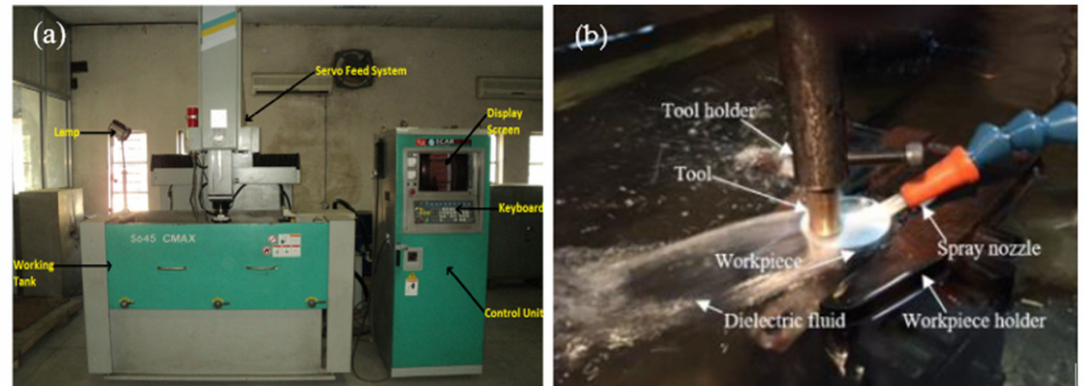
Figure 1. ( a ) EDM used for experimentation and ( b ) EDM machining.